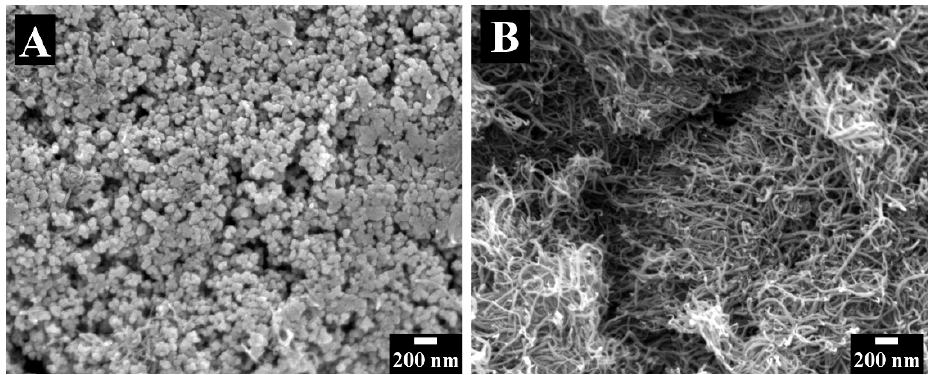
Figure 3. SEM images of electrode prepared without dispersant: ( A ) area of MnO 2 agglomerate and ( B ) area of CNT agglomerate.